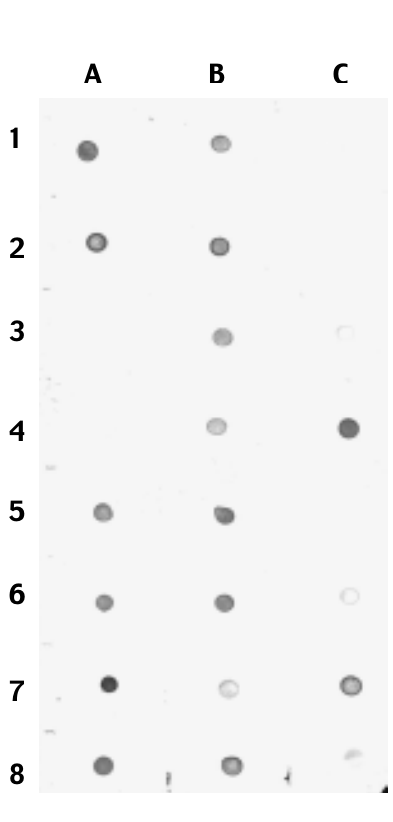
Fig. 3. Detection of membrane bound virions. Panel A: immunodot assay with diverse field samples from Reunion Island; negative controls are in column C, rows 1 and 2. Panel B: immunotissue prints of sections of healthy (column A) and infected (columns B and C) sweet orange stems. Amplified imprints of samples 3A and 2C show the difference between a weak positive reaction (2C) and a negative reaction (3A) in which too much pressure was exerted during the imprint